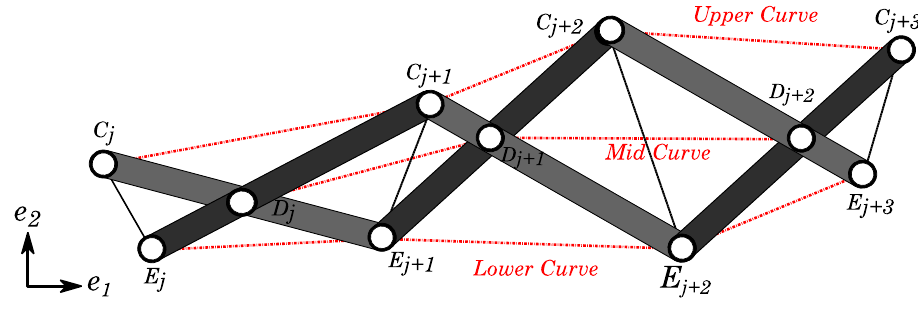
Figure 6. Curves that can be generated by a planar SSM.